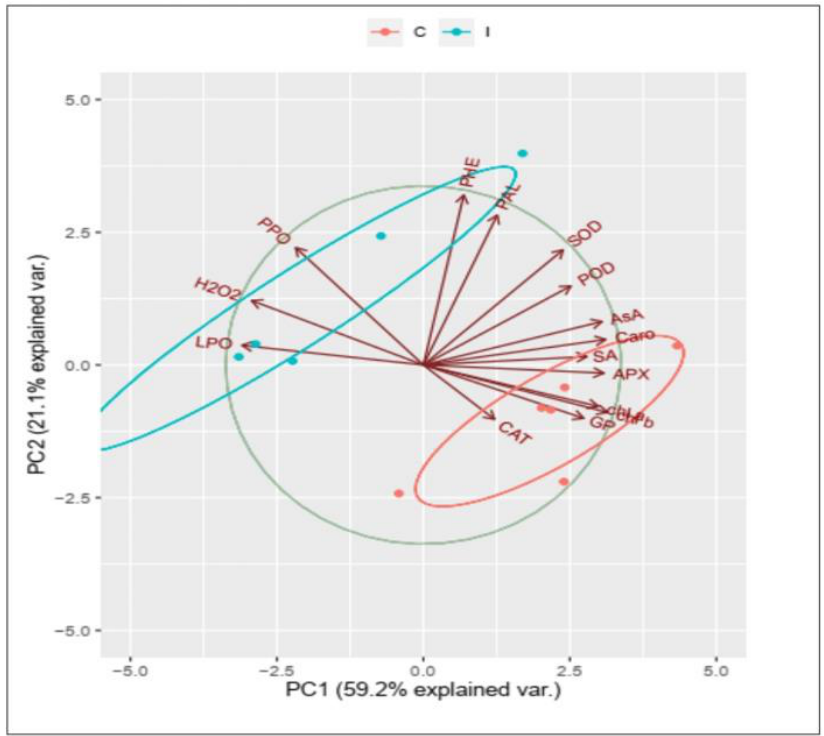
Figure 11. Principal component analysis (PCA) correlation of physiological traits of healthy and R. solani -infected coriander treated with biocontrol agents.